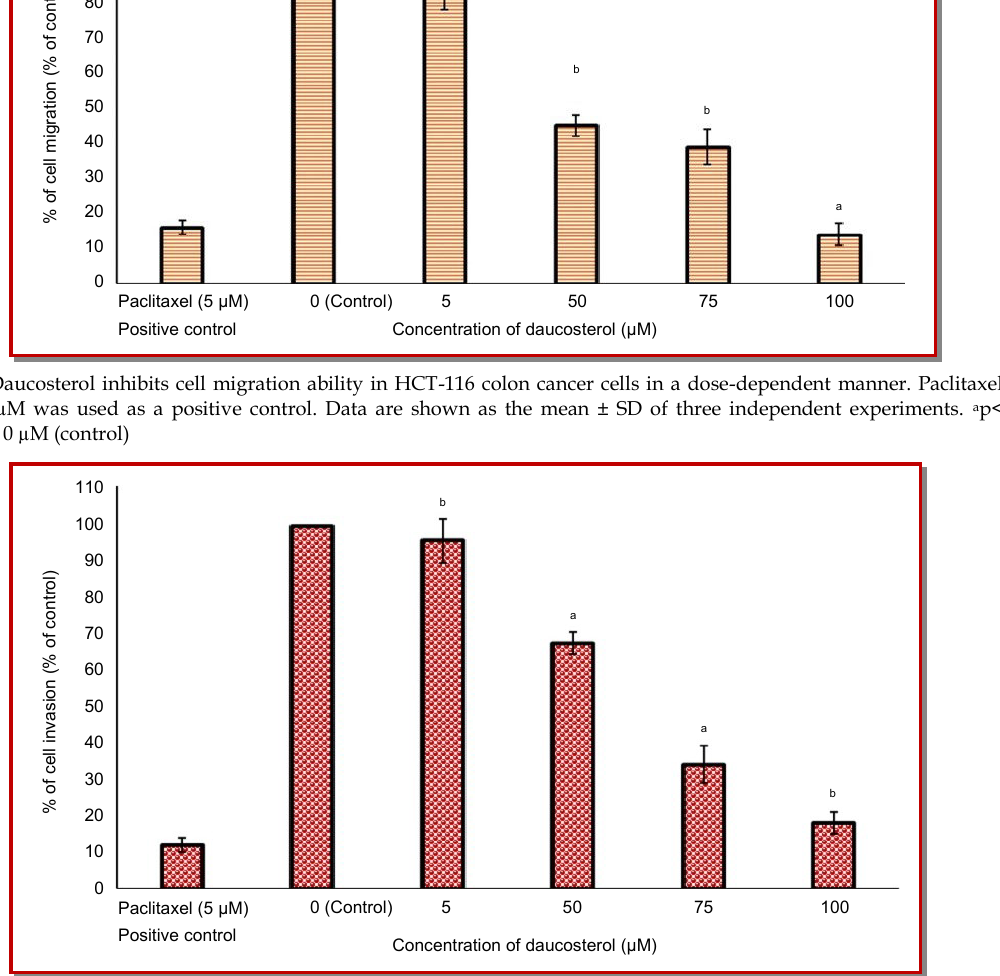
Figure 4: Daucosterol inhibits cell invasion ability in HCT-116 colon cancer cells. Paclitaxel at a dose of 5 µM was used as a posi- tive control. Data are shown as the mean ± SD of three independent experiments. a p<0.05, b p<0.01, vs 0 µM